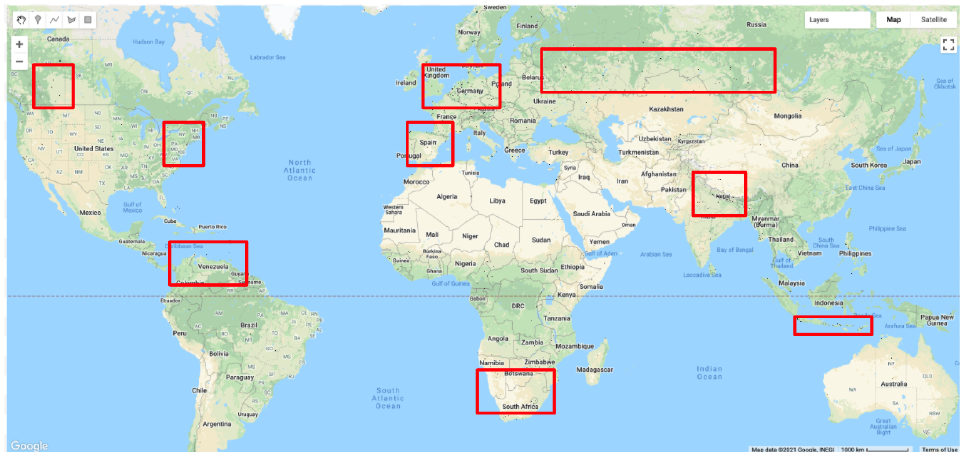
Figure 4. Map indicating 1958 patches sampled across various sites for model